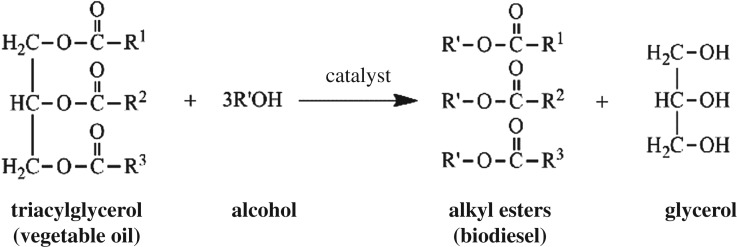
Reaction processes in the transesterification of VO [12].